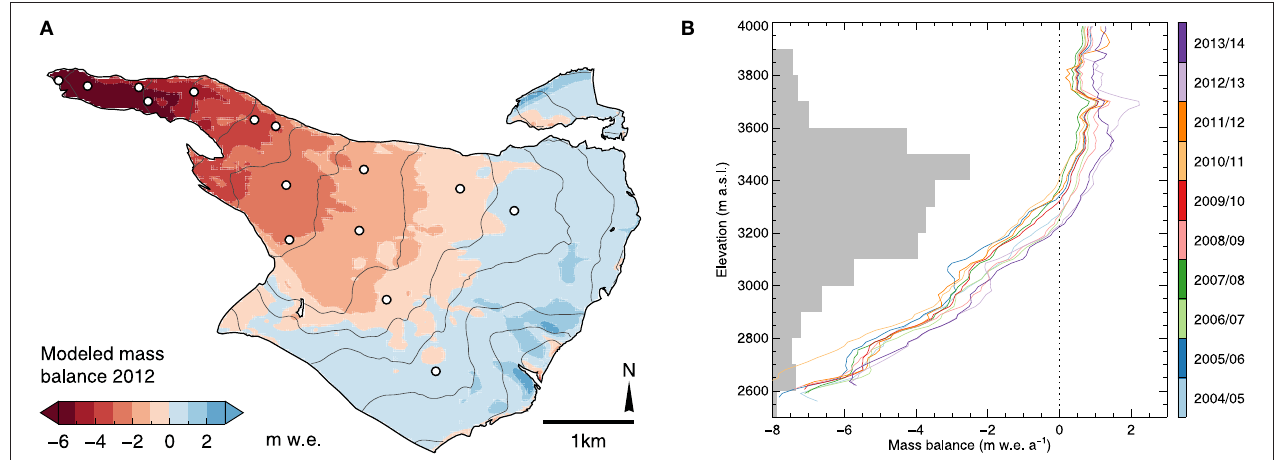
FIGURE 6 | (A) Map of glacier surface mass balance 2011/12 derived from model-based extrapolation of observations; dots show the locations of the respective point balance observations; gray lines are 100m elevation contours. (B) Vertical gradients in annual glacier mass balance derived from model-based extrapolation in 2004/05 to 2013/14. Gray horizontal bars show the area-elevation distribution of Findelengletscher.